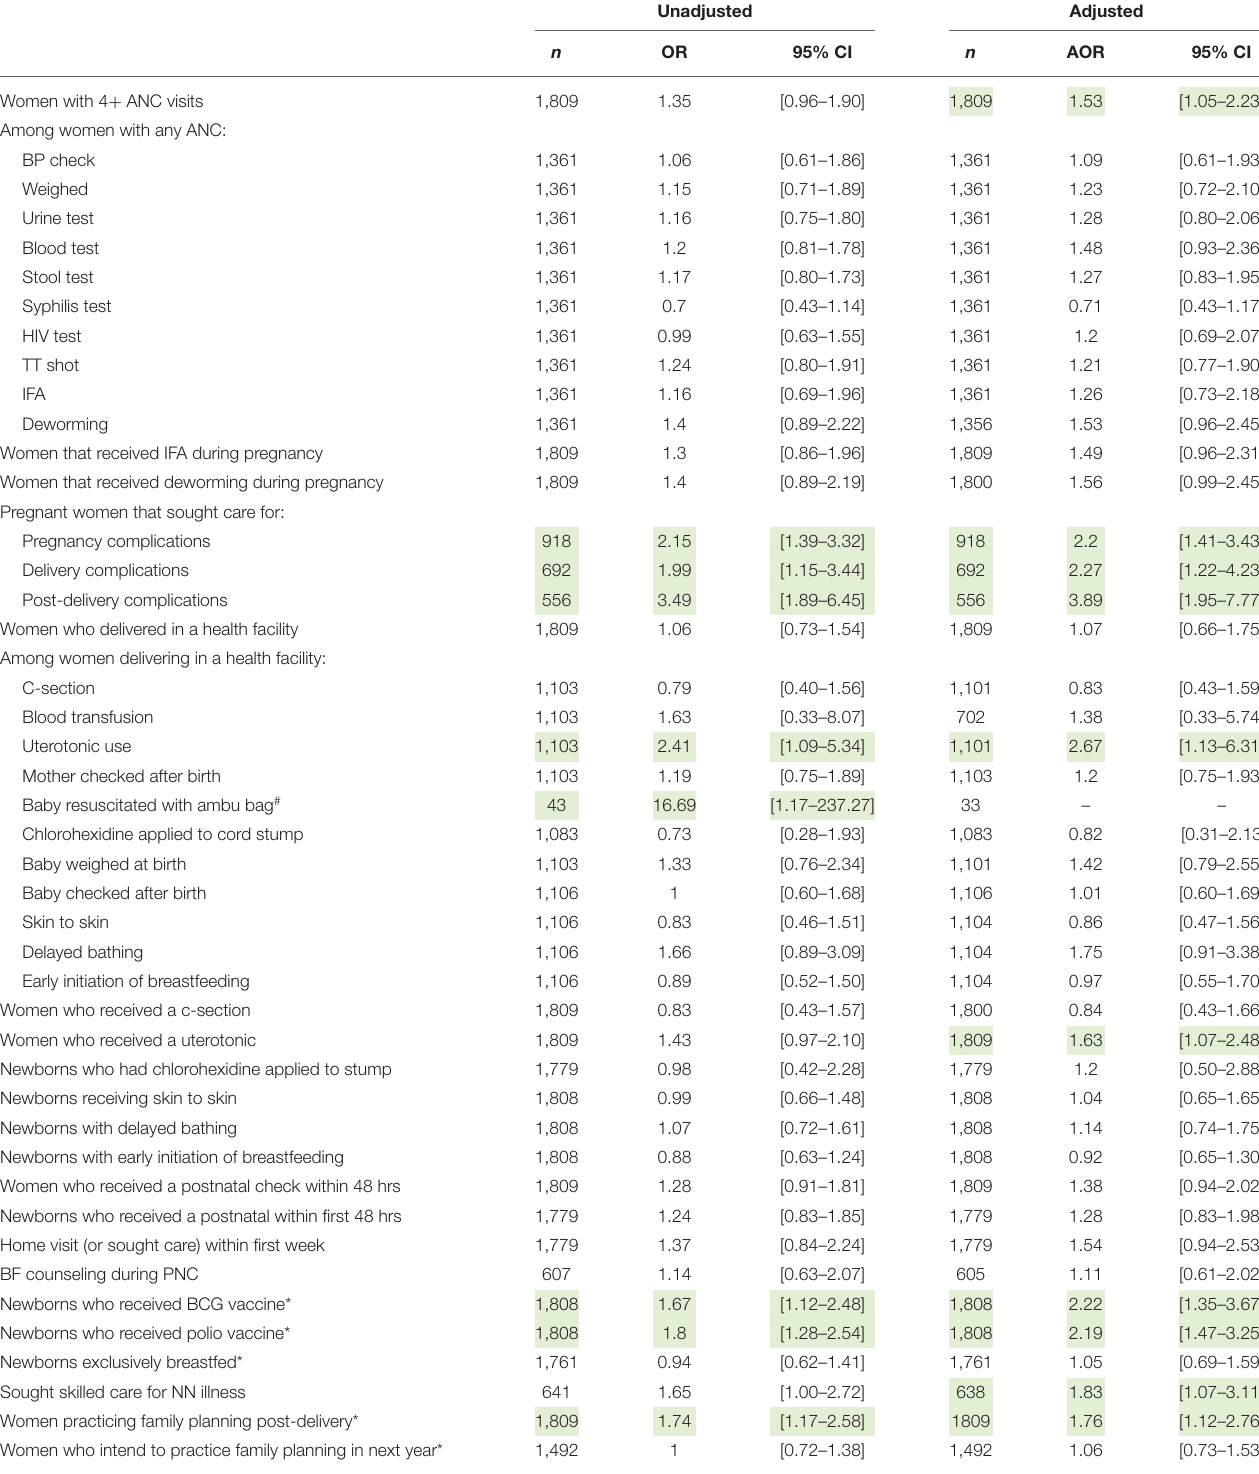
TABLE 2 | Odds of intervention receipt in COVID-19 impacted cohort vs. unaffected reference cohort at national level. Unadjusted Adjusted n OR 95% CI AOR 95%